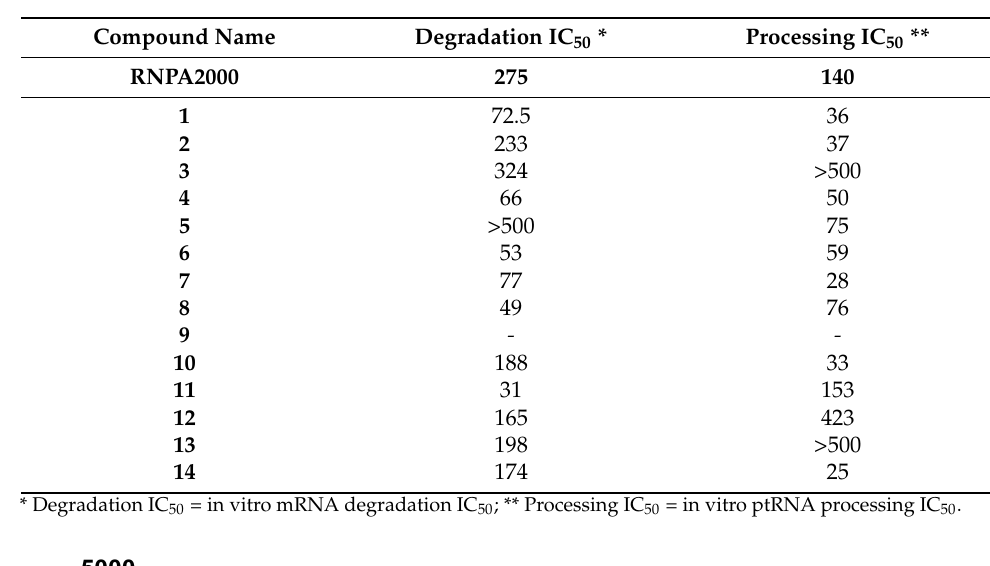
Table 2. IC 50 values of compounds 1 – 14 .